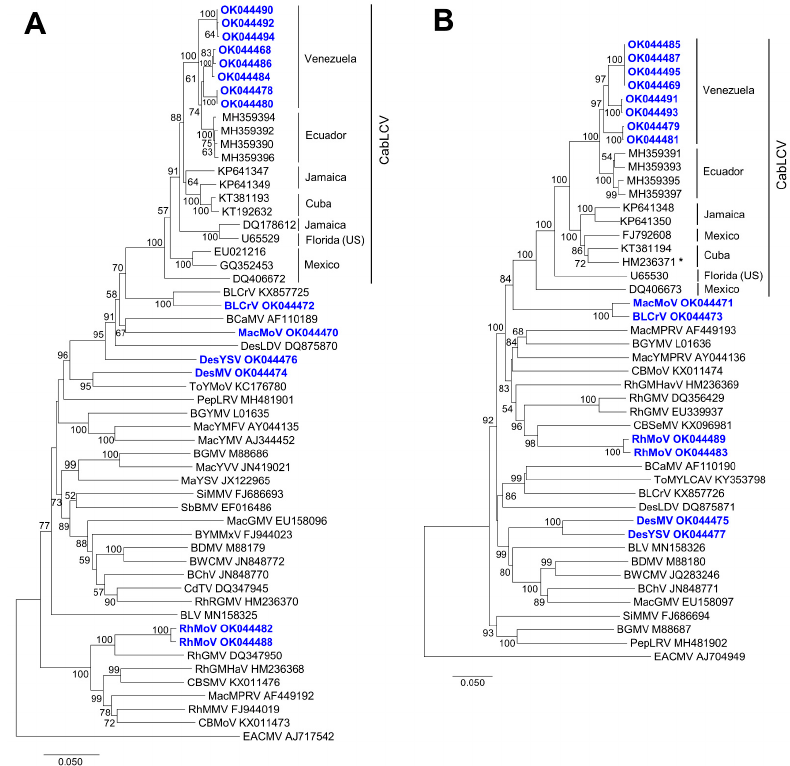
Figure 3. Phylogenetic tree illustrating the relationship of DNA-A ( A ) and DNA-B ( B ) from begomoviruses described in this work (BLCrV, bean leaf crumple virus; CabLCV, cabbage leaf curl virus; DesMV, Desmodium mosaic virus; DesYSV, Desmodium yellow spot virus; MacMoV, Macroptilium mottle virus; RhMoV, Rhynchosia mottle virus) to other New World begomoviruses. The tree was constructed by the neighbor-joining method (1000 replicates) with the MEGA 7 program [48]. GenBank accession numbers are shown in the tree and the names of the viruses follow: BCaMV, bean calico mosaic virus; BChV, bean chlorosis virus; BDMV, bean dwarf mosaic virus; BGMV, bean golden mosaic virus; BGYMV, bean golden yellow mosaic virus; BLCrV, bean leaf crumple virus; BLV, bean latent virus; BWCMV, bean white chlorosis mosaic virus; BYMMxV, bean yellow mosaic Mexico virus; CBMoV, common bean mottle virus; CBSMV, common bean severe mosaic virus; CdTV, chino del tomate virus; DesLDV, Desmodium leaf distortion virus; MacGMV, Macroptilium golden mosaic virus; MacMPRV, Macroptilium mosaic Puerto Rico virus; MacYMFV, Macroptilium yellow mosaic Florida virus; MacYMV, Macroptilium yellow mosaic virus; MacYSV, Macroptilium yellow spot virus; MacYVV, Macroptilium yellow vein virus; PepLRV, pepper leafroll virus; RhGMHaV, Rhynchosia golden mosaic Havana virus; RhGMV, Rhynchosia golden mosaic virus; RhMMV, Rhynchosia mild mosaic virus; RhRGMV, Rhynchosia rugose golden mosaic virus; SbBMV, soybean blistering mosaic virus; SiMMV, Sida micrantha mosaic virus; ToYMoV, tomato yellow mottle virus. * HM236371 corresponds to DNA-B of RhRGMV. The OW begomovirus East African cassava mosaic virus (EACMV) was used as an outgroup. Bootstrap values are shown for supported branches (>50%). The bars below the trees indicate the number of nucleotide substitutions per